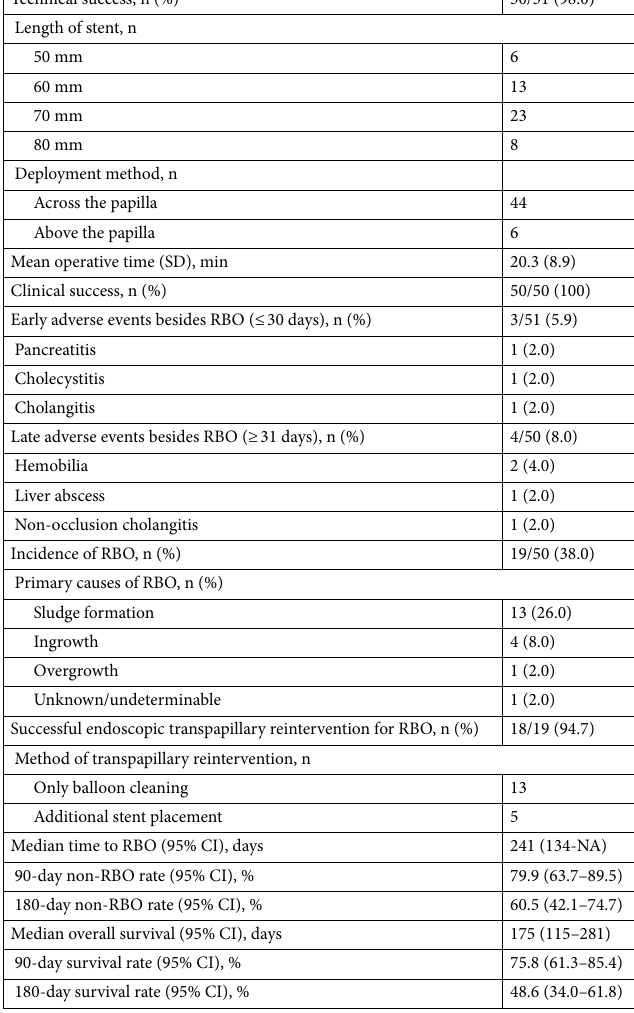
Table 2. Outcomes of double bare metal stent deployment combined with radiofrequency ablation for malignant distal biliary obstruction. SD standard deviation, RBO recurrent biliary obstruction, CI confidence interval, NA not